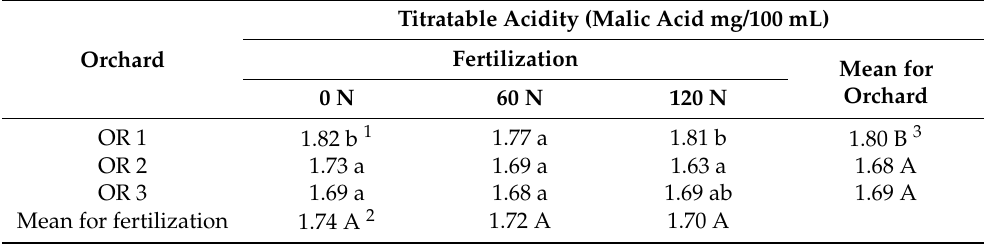
Table 9. Influence of fertilization on titratable acidity of sour cherry cv. ‘Łut ó wka’ fruits in 2006–2013.